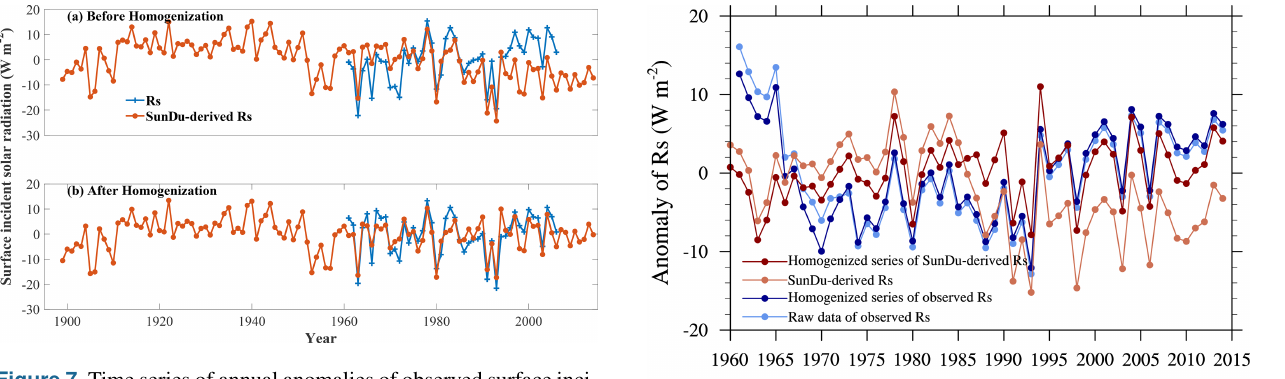
Figure 7. Time series of annual anomalies of observed surface inci- dent solar radiation ( R s ) and SunDu-derived R s at the Hamada site (WMO ID: 47755; lat 34.9, long 132.07) before and after homoge- nization.